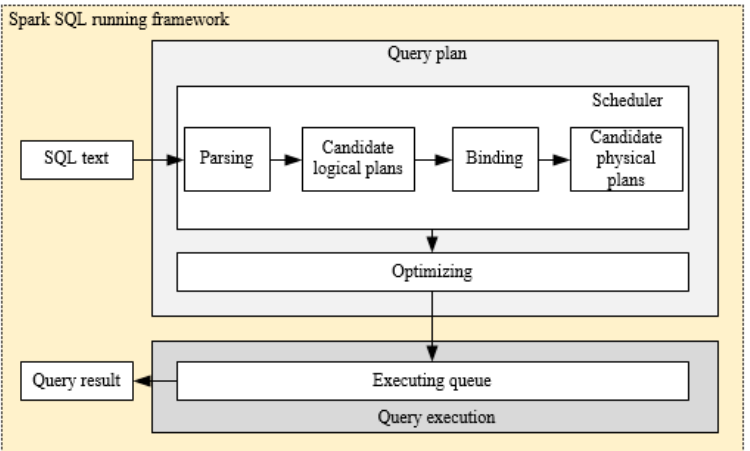
Figure 1. Running framework of Spark SQL.